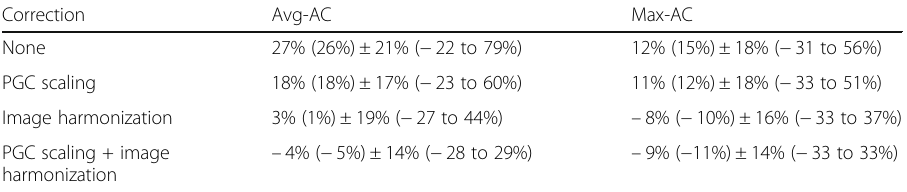
For comparison purposes, we also determined the ACs without image harmonization and PGC scaling. In Table 2, an overview of the statistics of the percentage difference between MR-based and CT-based AC for different corrections (none, PGC scaling, image harmonization) are listed. The corresponding percentage difference without any corrections is shown in Fig. 1c, d. Likewise, excluding 2 lesions, the mean (median) ± SD (range) of the percentage AC difference was considerably larger, that is, 26% (27%) ± 21% ( − 22 to 79%) for the avg-AC and 15% (12%) ± 18% ( − 31 to 56%) for the max- Table 2 Statistics of the percentage difference between MR-based and CT-based AC for different correction approaches (excluding two lesions considered as outliers) Correction Avg-AC Max-AC None 27% (26%) ± 21% ( − 22 to 79%) 12% (15%) ± 18% ( − 31 to 56%) PGC scaling 18% (18%) ± 17% ( − 23 to 60%) 11% (12%) ± 18% ( − 33 to 51%) Image harmonization 3% (1%) ± 19% ( − 27 to 44%) – 8% ( − 10%) ± 16% ( − 33 to 37%) – 4% ( − 5%) ± 14% ( − 28 to 29%) – 9% ( − 11%)± 14% ( − 33 to 33%) PGC scaling + image harmonization Statistics included the mean, the median, the SD, the minimum, and the maximum, which are provided in the following form: mean (median) ± SD (minimum to maximum). None means without any corrections. PGC scaling refers to only application of scaling factors. Image harmonization refers to only corrections pertaining to image reconstruction parameters. PGC scaling + image harmonization means application of both corrections, PGC scaling and image harmonization